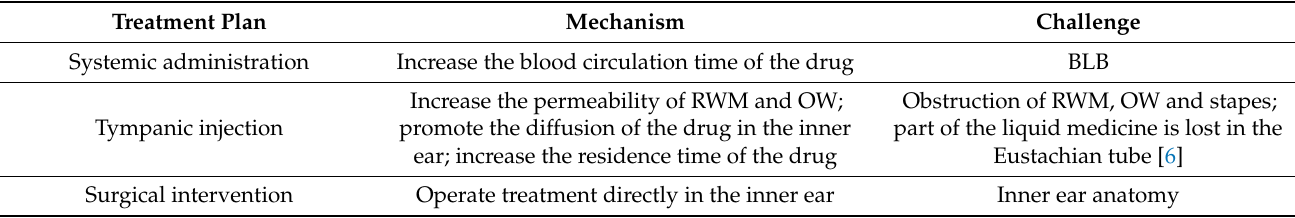
Figure 1. Inner ear anatomy. The most critical microvascular network in the cochlea is located in the cochlear stria vascularis. This vascular network receives a larger portion of the cochlear blood flow. The microvascular bed in this area also constitutes a tightly controlled BLB, rich in pericytes, and provides timely oxygen and nutrients for the cochlea. Cisplatin enters the cochlea from the bloodstream mainly through capillaries in the stria vascularis. Cisplatin may enter the endolymph through organic cation transporter 2 (OCT2) and copper transporter 1 (CTR1) of marginal cells. Table 1. Mechanism and challenges of inner ear treatment plan.